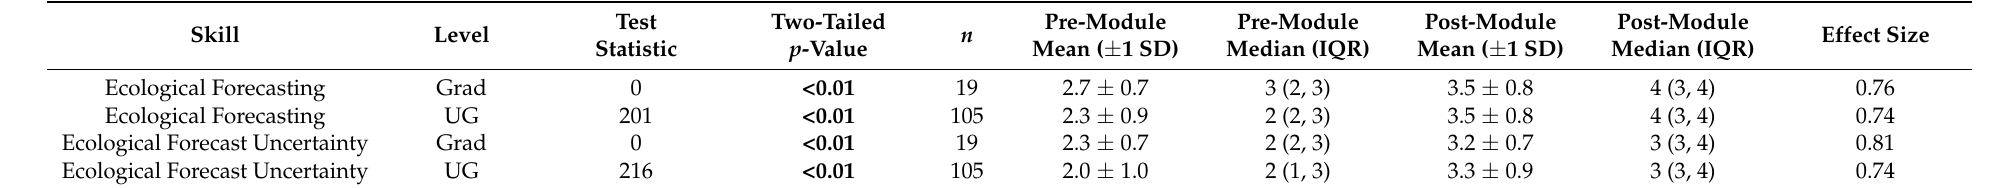
Table A10. Differences in students’ self-reported familiarity with ecological forecasting and ecological forecast uncertainty between pre- and post-module assessments for graduate (Grad) and undergraduate (UG) level of students. Test statistics and p -values are for paired, two-sided Wilcoxon signed-rank tests; pre- and post-module means are reported with the standard deviations (SD) along with pre- and post-module medians and the interquartile range (IQR). Significant p-values ( p < 0.05) are shown in bold. Questions used a Likert-type scale from 1 (low) to 5 (high) (S2).